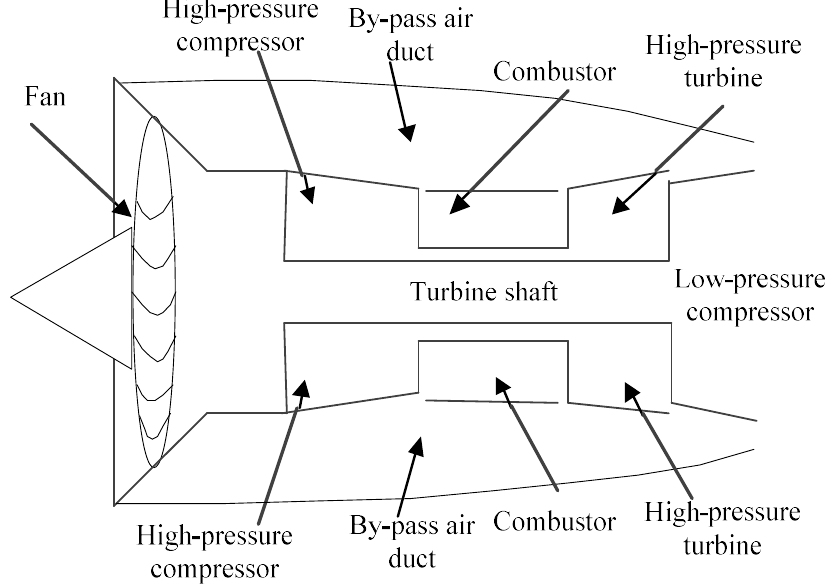
Figure 2. Schematic diagram of turbofan engine structure.